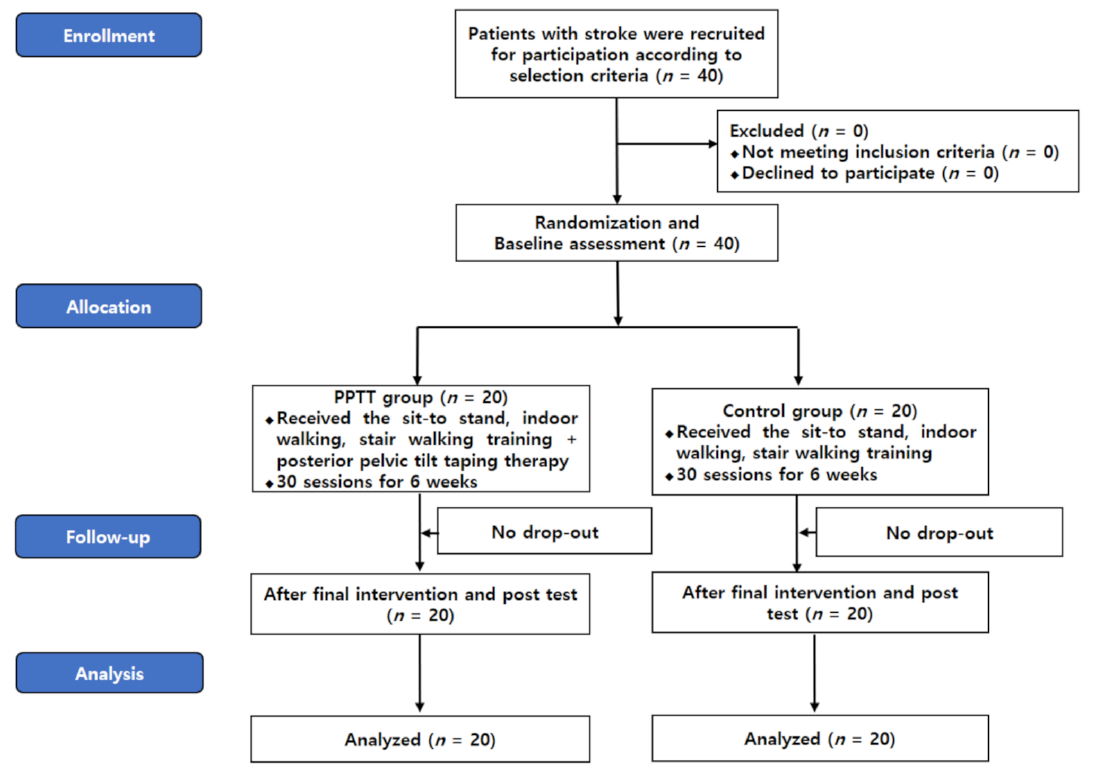
Figure 1. CONSORT flow diagram. Table 1. Common and clinical characteristics of the subjects (N =